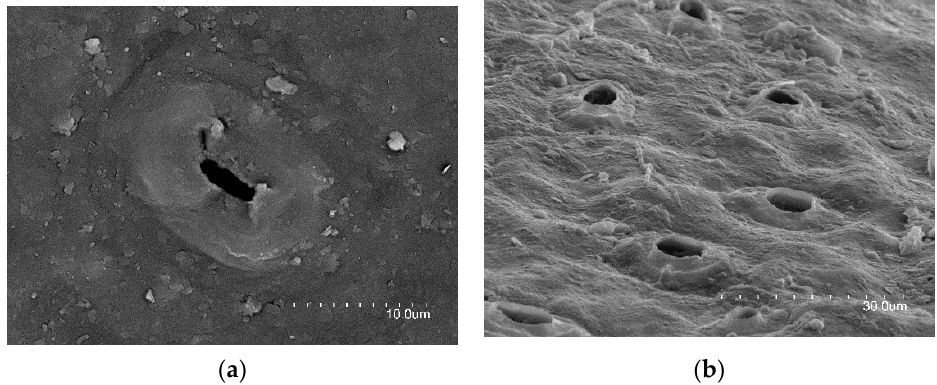
Figure 6. Stomatal encryption with epicuticular waxes in Q. coccifera living in hot and dry atmospheres ( a and b ).